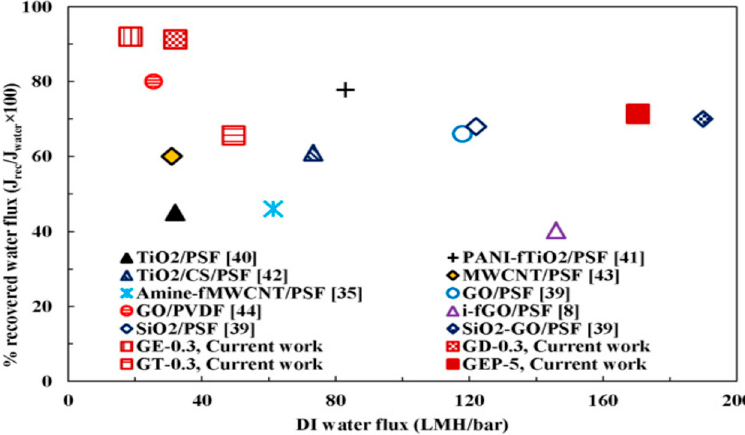
Figure 11. Comparison of the performance of membranes for different fillers-polymer mixed matrix ultrafiltration membranes in terms of hydrophilicity and antifouling properties. (Reproduced with permission after [87]).